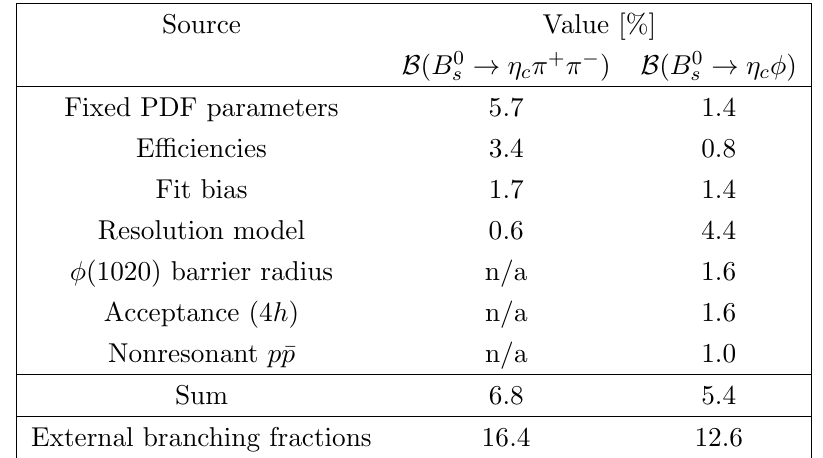
Table 6 . Summary of systematic uncertainties. The \Sum" of systematic uncertainties is obtained from the quadratic sum of the individual sources, except the external branching fractions, which are quoted separately. All values are in % of the measured branching fractions. The abbreviation \n/a" stands for \not